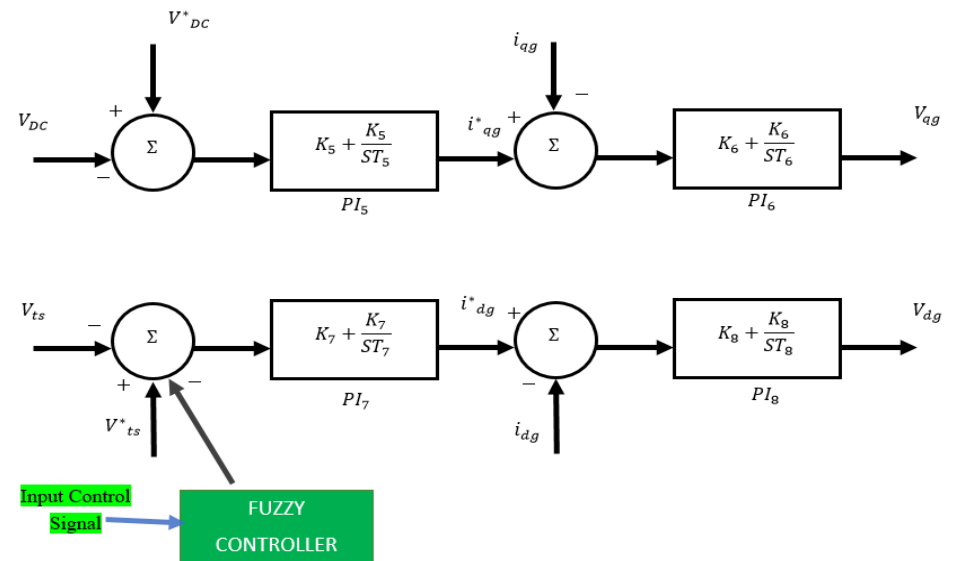
Figure 6. Location of Fuzzy logic System.